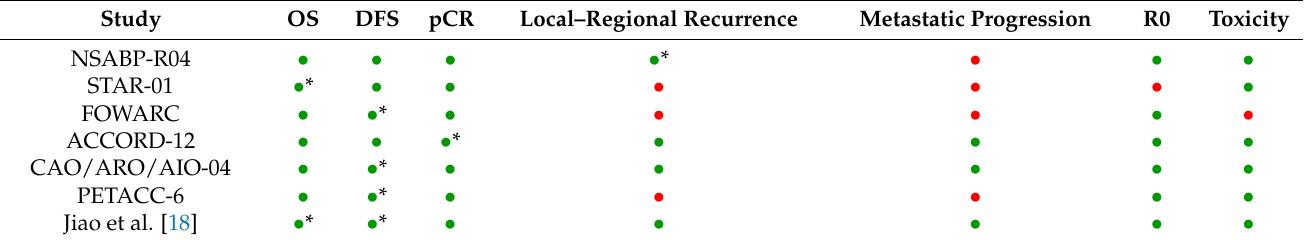
Table 2. Study-reported